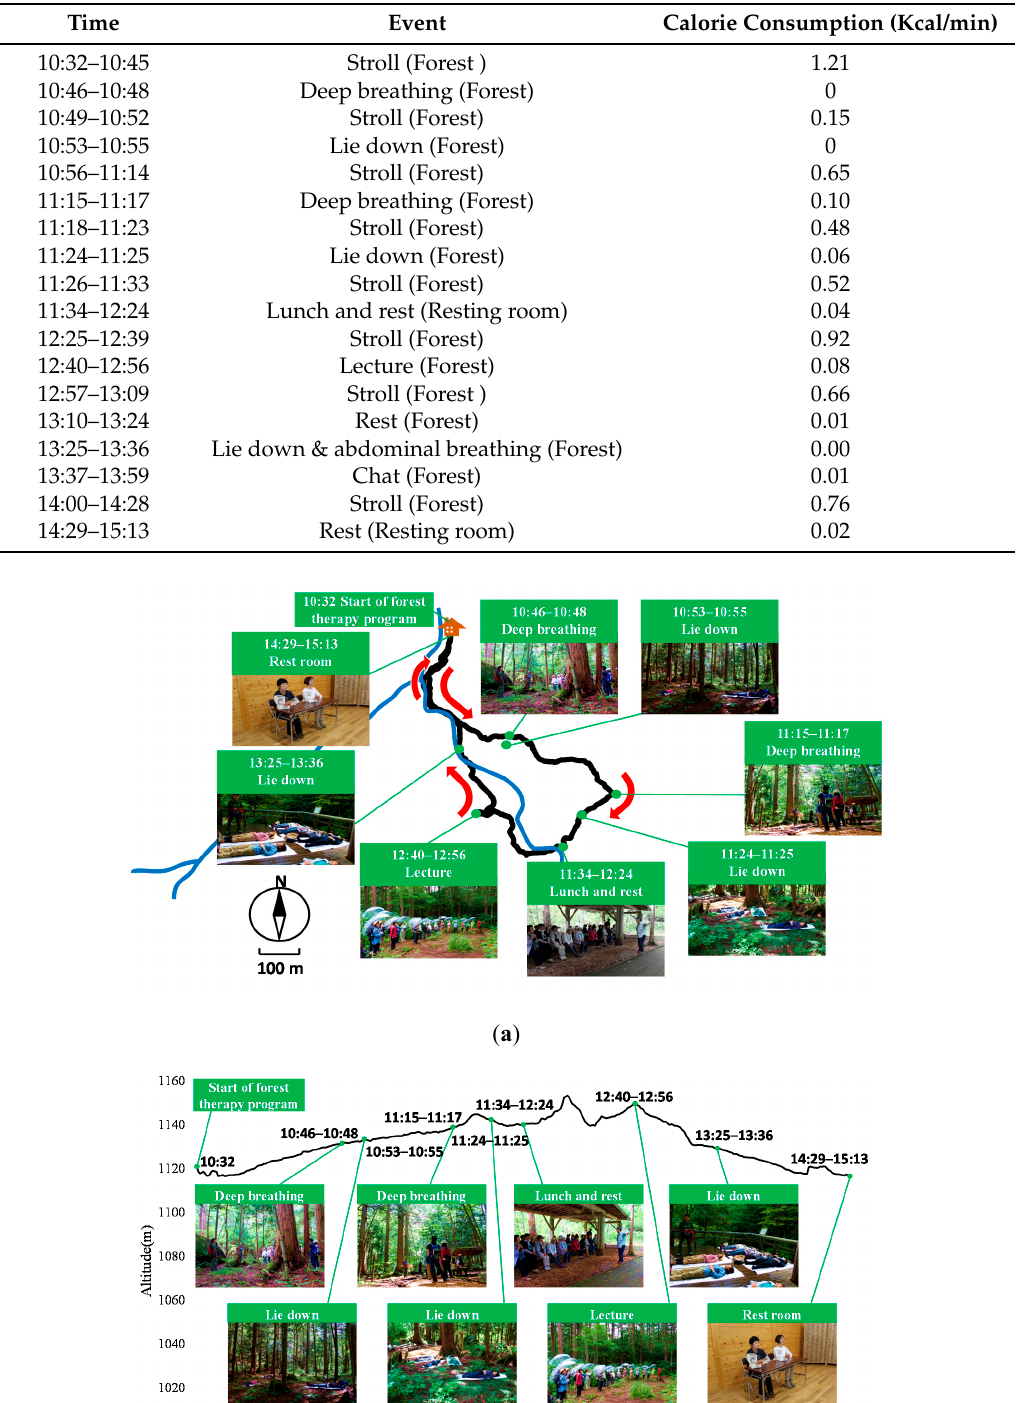
Table 1. Time schedules and calorie consumption during various activities of the forest therapy program.